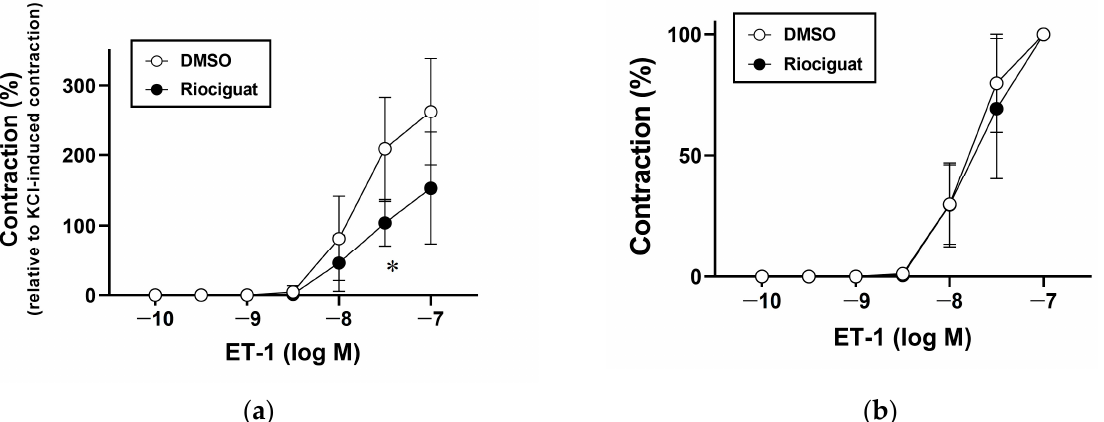
Figure 2. Effect of soluble guanylate cyclase stimulator riociguat on concentration–contraction relationship for endothelin (ET)-1 in an isolated endothelium-denuded canine pulmonary artery. Riociguat (100 nM, n = 5 rings) or dimethyl sulfoxide (DMSO; solvent of riociguat, n = 5 rings) was pretreated for 15 min before the application of ET-1. ET-1 (0.1 nM to 100 nM) was cumulatively applied. Each contraction was normalized to the ( a ) high-concentrated KCl- or ( b ) ET-1-induced maximal contraction. Results were expressed as means ± SD. * p < 0.05 vs. DMSO.